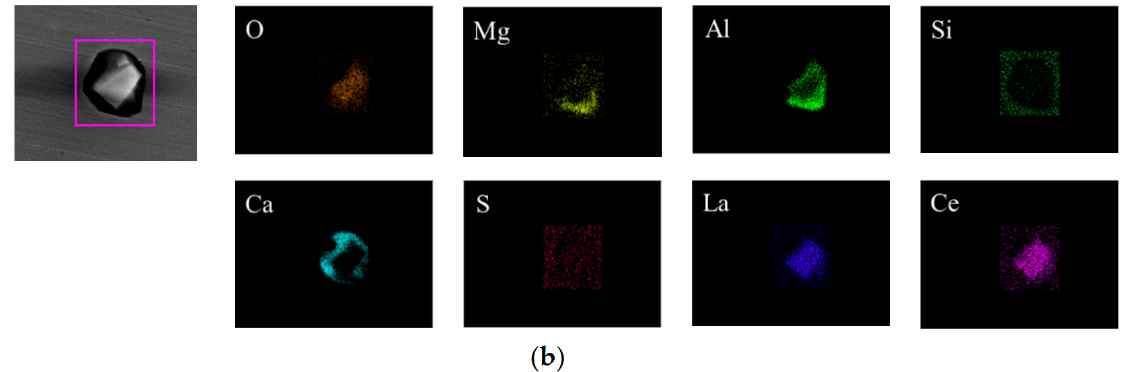
Figure 3. Surface scanning results for inclusions, with rare earth treatment. ( a ) (La, Ce)Al 2 O 3 +CaS- CaO-Al 2 O 3 , ( b ) (La, Ce)Al 2 O 3 +CaO-Al 2 O 3 -MgO .